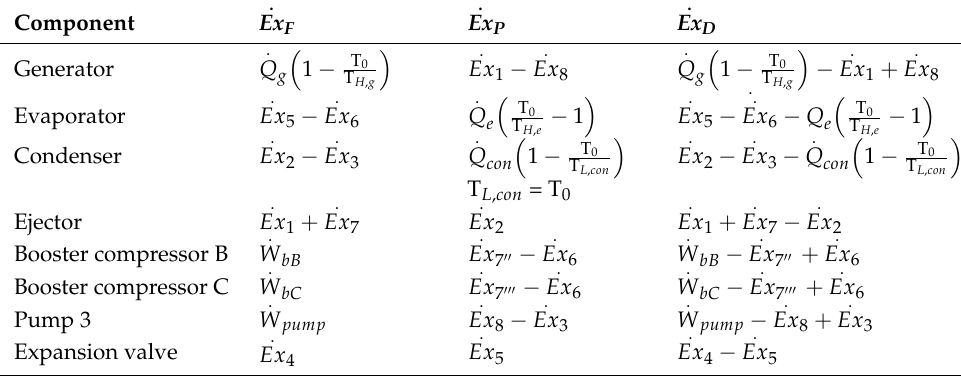
Table 4. Exergy relations for the refrigeration sub-system components